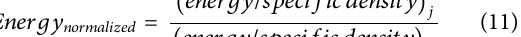
Frontiers in Mechanical Engineering |